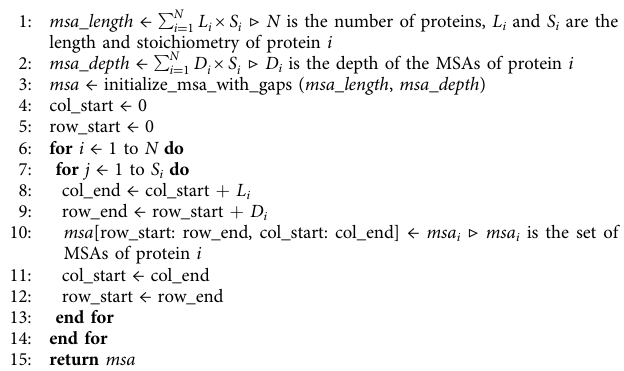
Algorithm 1 . Complex MSA Creation def make_complex_msa